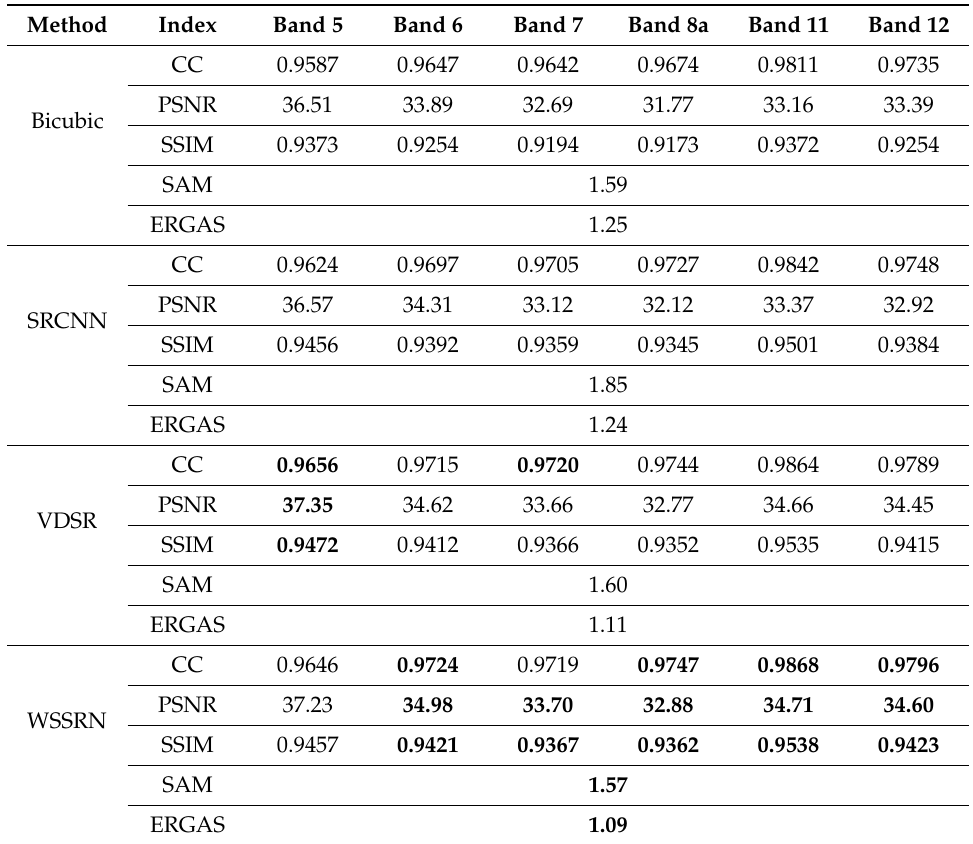
Table 4. Quantitative evaluation for the simulated experiment with the same center